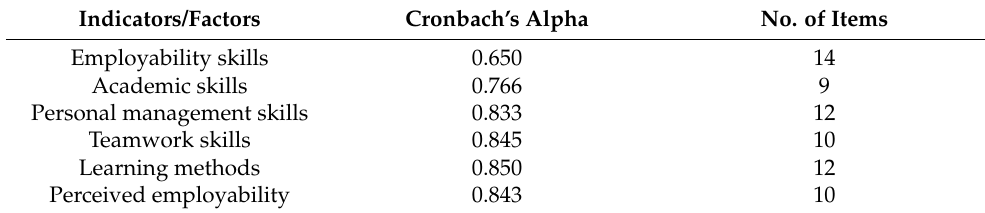
Table 2. Internal consistency reliabilities for